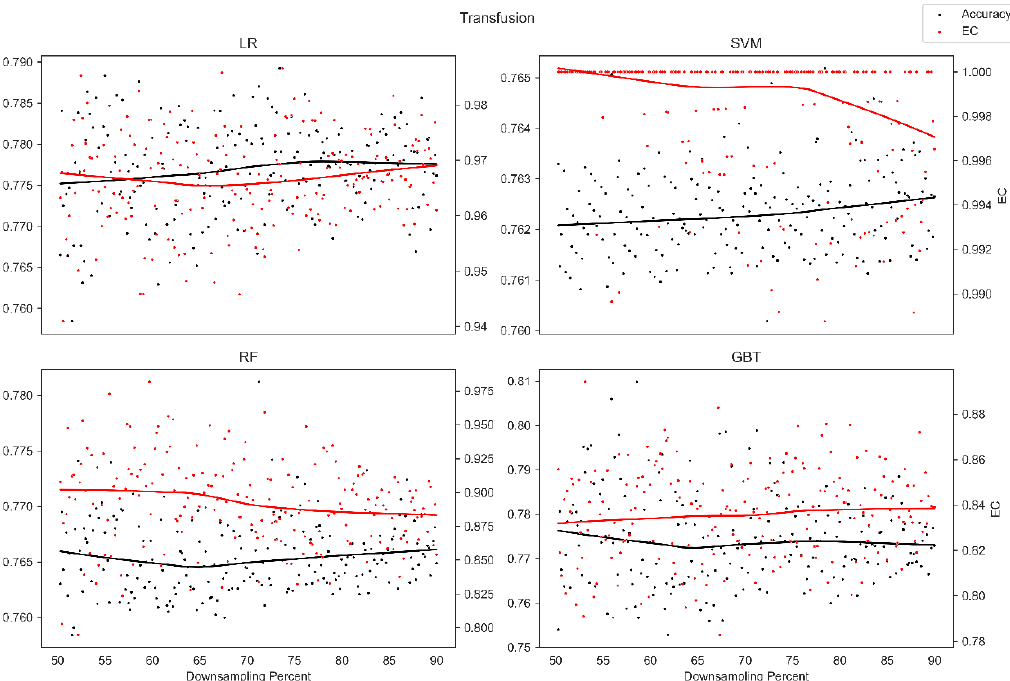
Figure 1. Average error consistency and overall accuracy vs. varying sample size percentages (down-sampled) from the UTI Resistance dataset. Trend lines were established with locally weighted regression and smoothing [25].